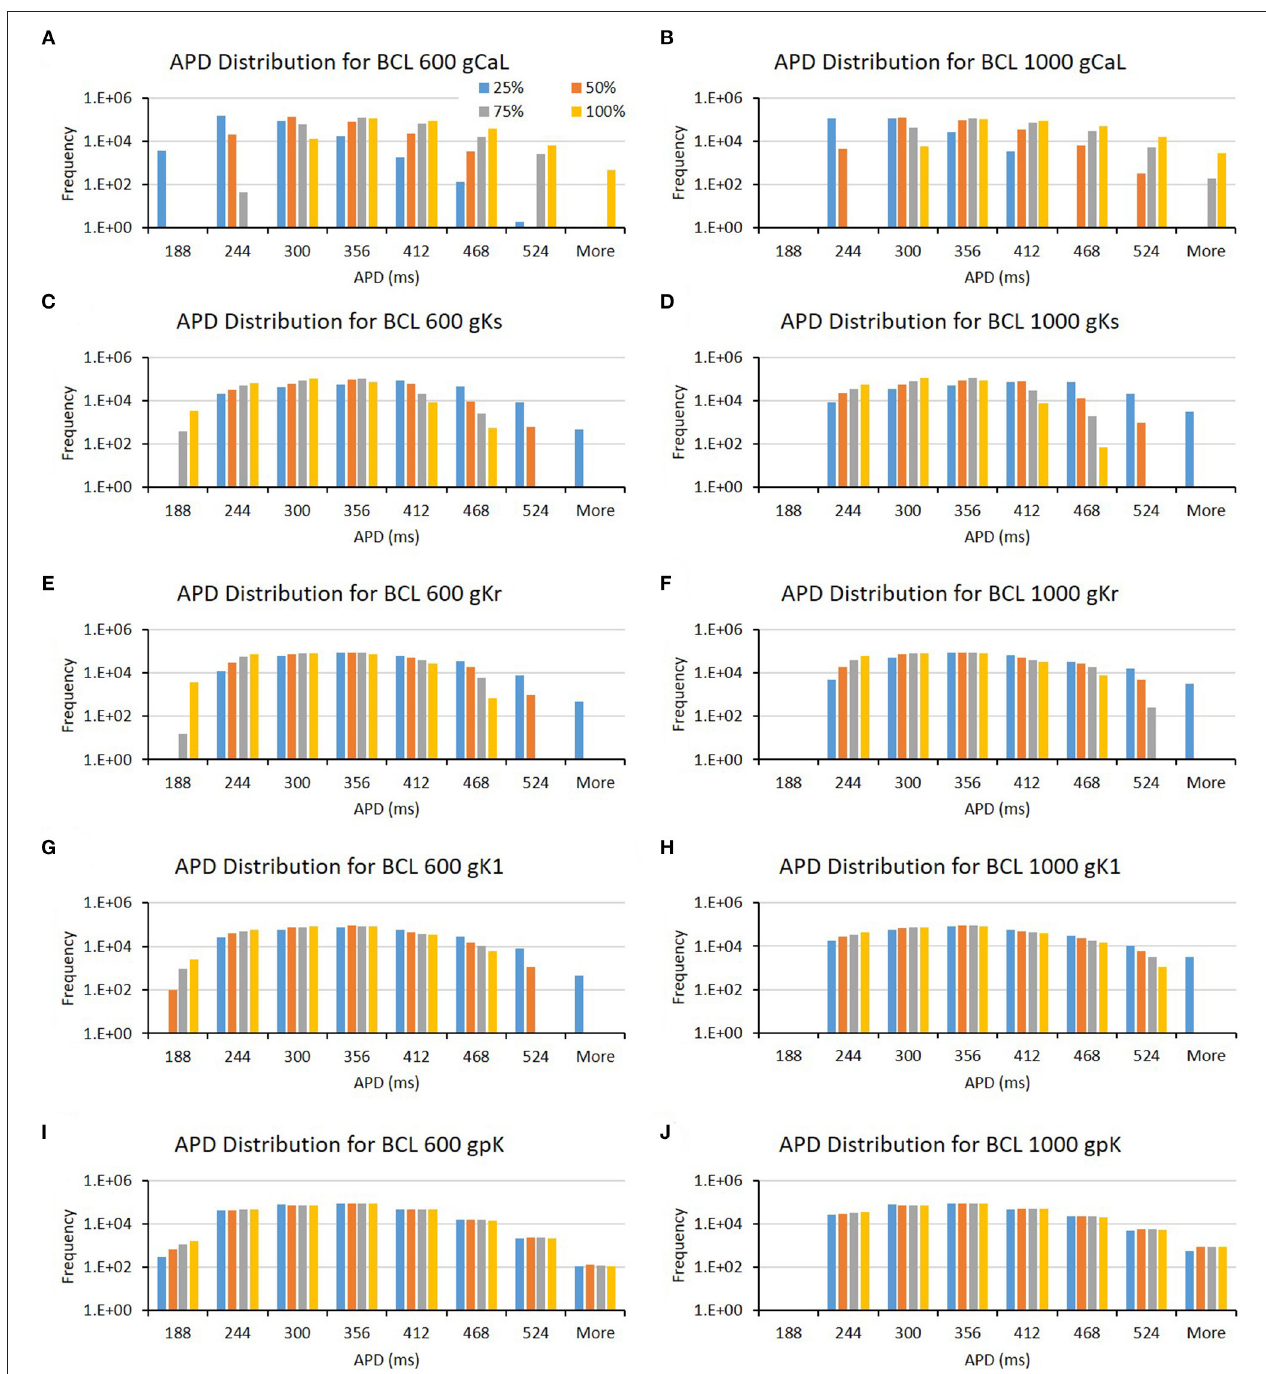
FIGURE 4 | The bar charts show the influence of major ion channels (based on Table 1 ) for prolonging APD [for BCL 600ms (A,C,E,G,I) and for BCL 1,000ms (B,D,F,H,J) ]. The x-axis is the APD groups in milliseconds, and the y-axis is the frequency (number of appearance of APD groups) in logarithmic scale. Four conductance variations are applied